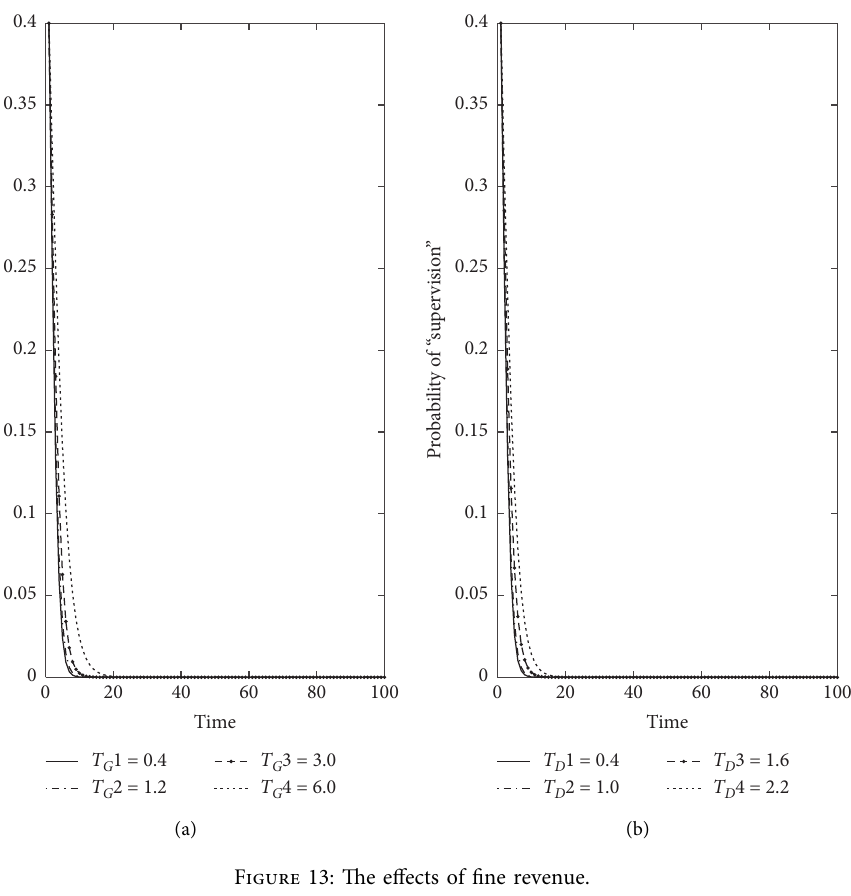
Figure 13: The effects of fine revenue.